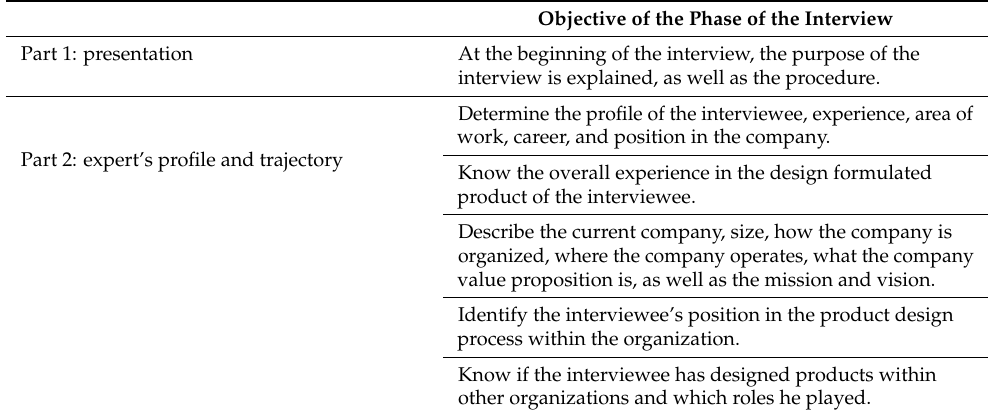
Table 1. Interview protocol applied to chemical product design